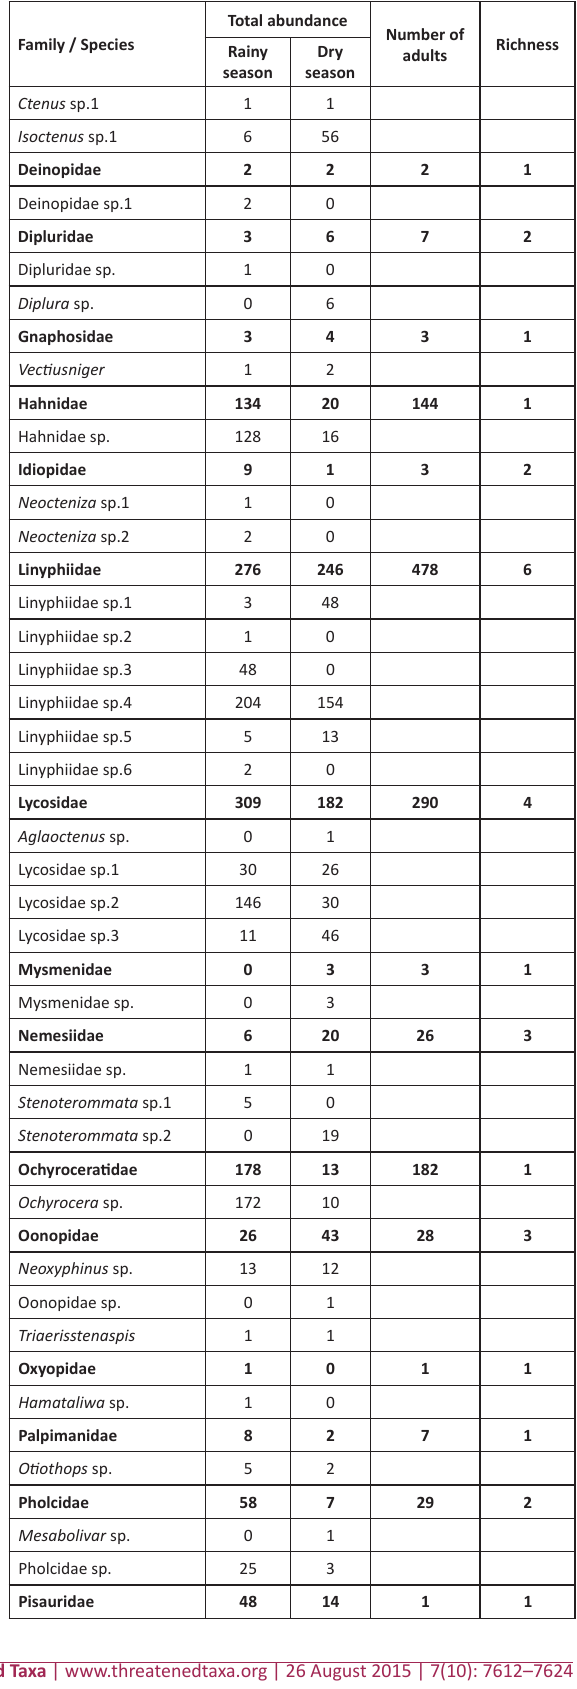
Table 1. List of morphospecies/species collected in semi-deciduous forest in the municipality of Morrinhos -